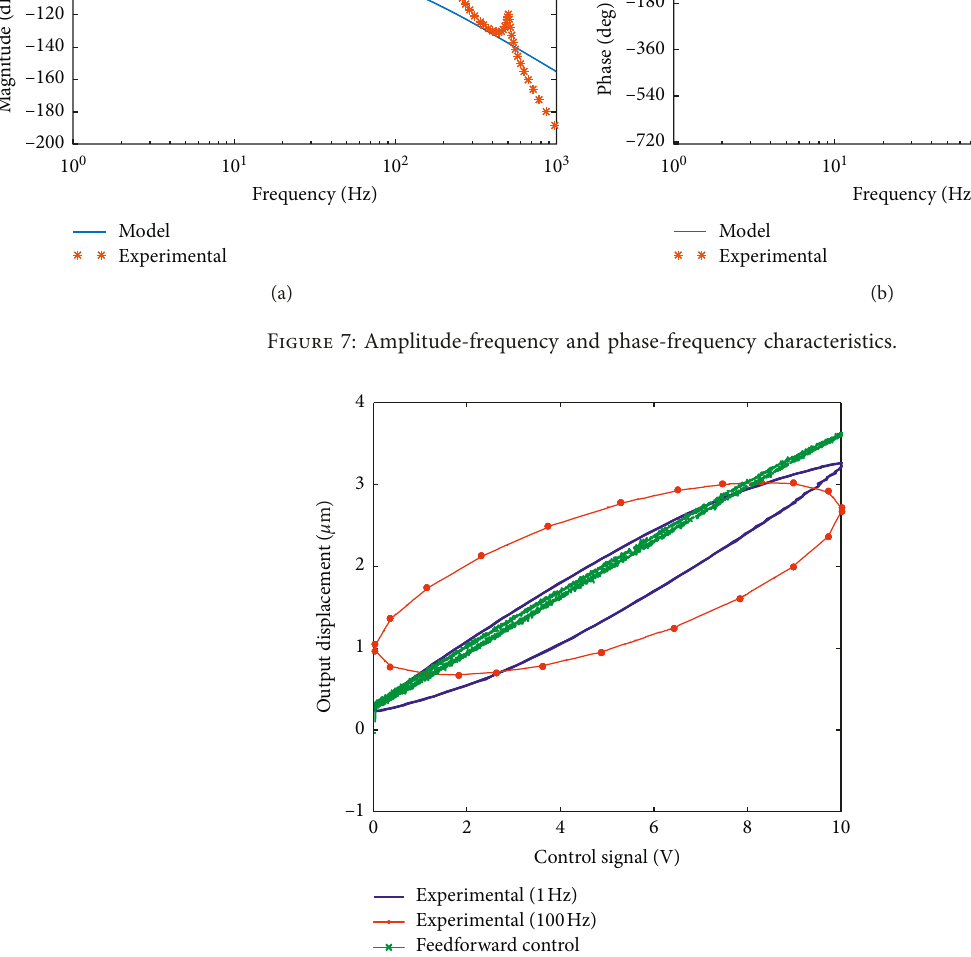
Figure 8: Comparisons of the output-input characteristics of the stage with and without the feedforward